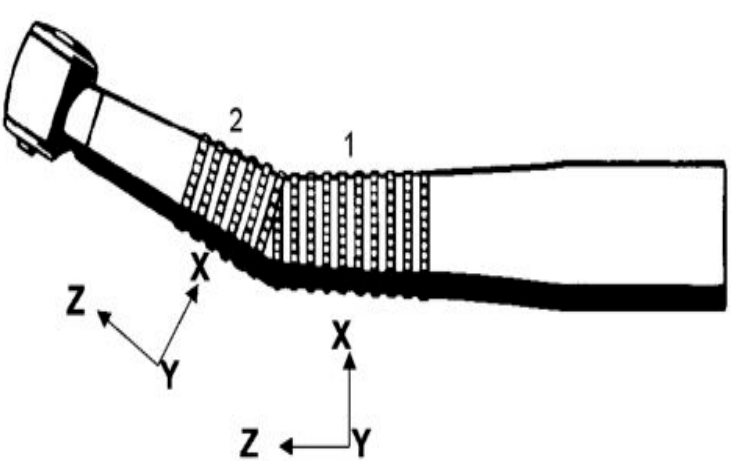
Figure 1. Location of measurement position and directions on air-turbine hand piece [32].